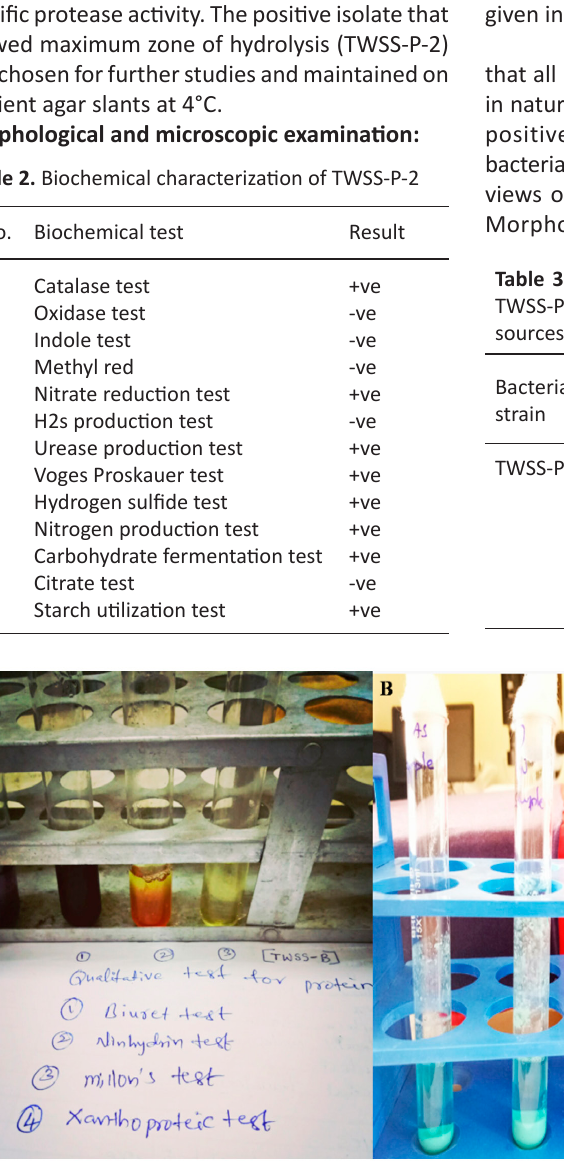
Fig. 2. (A) Qualitative test for Std.Protein and Test Sample.(B) Quntitative Test for Protein by Lowry ´ s